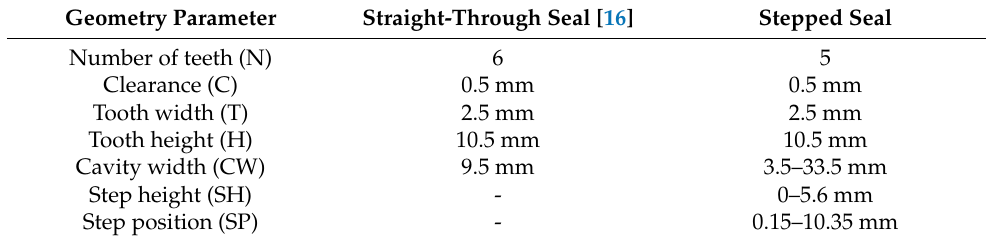
Figure 3. Grid test using the discharge coefficient. Table 1 lists the length of each shape of the labyrinth seal. Because the labyrinth seal has a limited axial length, the straight labyrinth seal was adjusted to contain six teeth and the stepped labyrinth seal to have a five-tooth structure. The shape variables in this study were analyzed by selecting CW, SH, and SP. CW* and SH* were normalized to clearance, and SP* was normalized to the cavity width. Table 1. Geometrical parameters of the labyrinth seals.